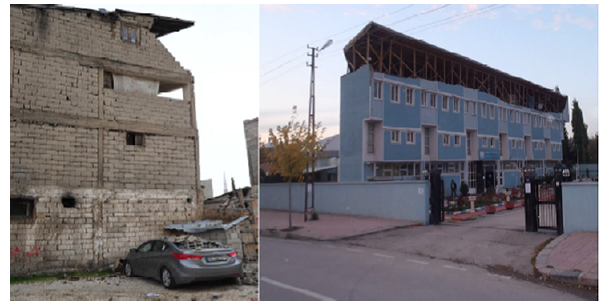
Figure 23. Gable wall damage (www.dramaistanbul.com.tr).